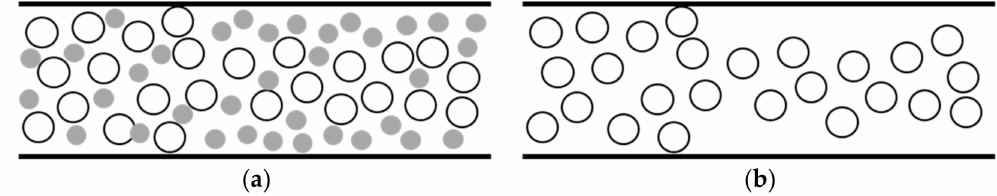
Figure 2. Schematic representation of the segregation principle of shear induced diffusion for a bidisperse ( a ) and monodisperse ( b ) suspension.